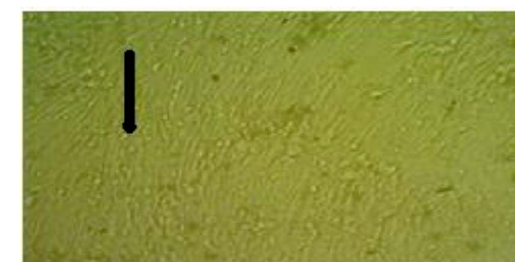
Fig.1. Tissue culture of fetal calves’ kidney (normal cell). We can clearly see the cells before being infected with the virus and the mangifera extract.